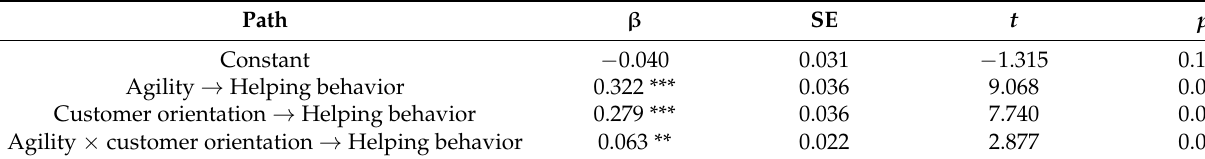
Table 10. Moderating effect for non-ICT companies.